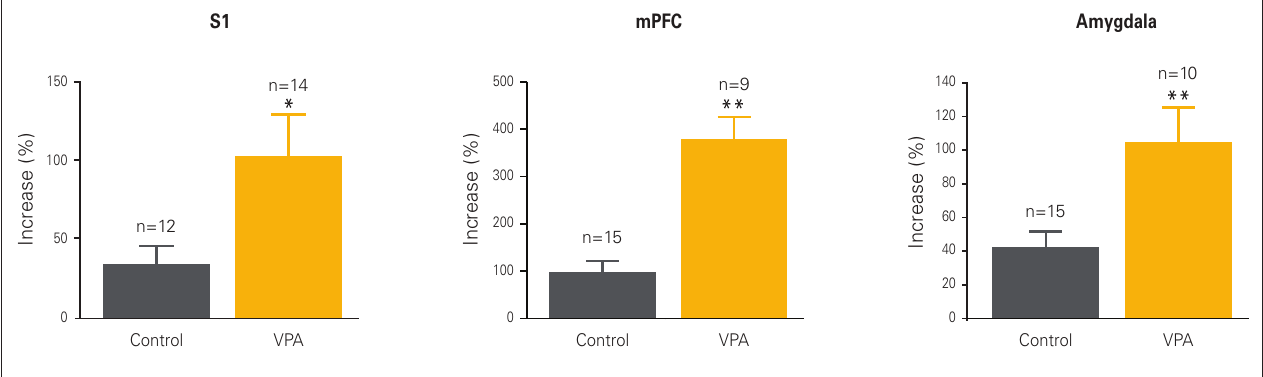
controls across all three recorded brain regions, the somatosensory cortex (S1), the medial prefrontal cortex (mPFC) and the lateral amygdala. Results rearranged from original research articles (Rinaldi et al., 2007, 2008a; Markram et al., 2008), with permission from PNAS , Neurospychopharmacology , and Frontiers in Neural Circuits